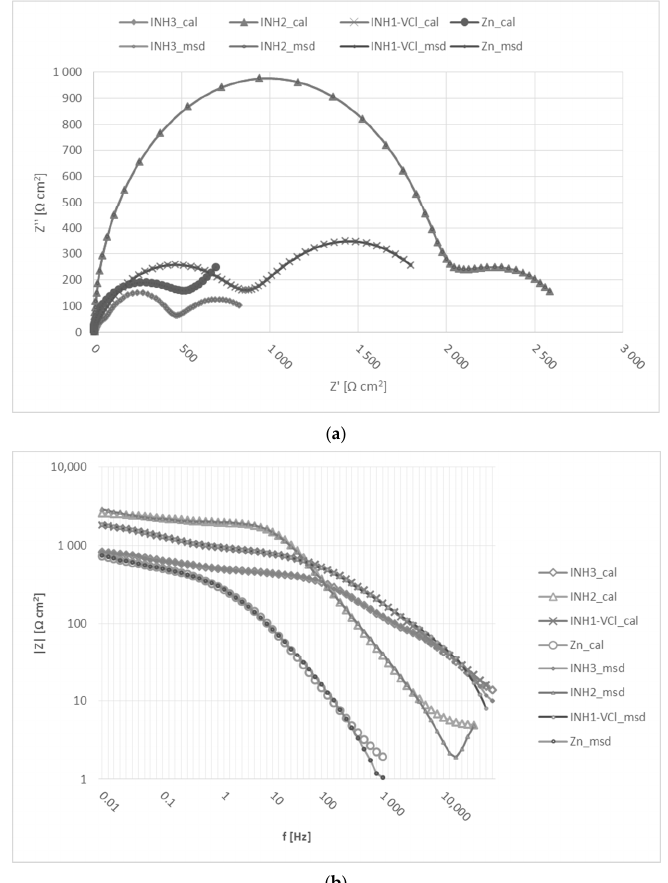
Figure 7. The Nyquist diagram ( a ) and Bode diagram ( b ) of tested Zn sample, Inhibitor 1-VCI, Inhibitor 2 and Inhibitor 3 after 24 h immersion in 1% NaCl solution. Metals 2020 , 10 , x FOR PEER REVIEW